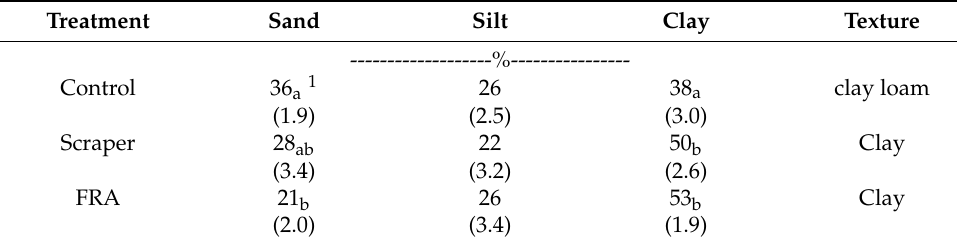
Table 1. Mean soil particle size distribution and textural class for each treatment followed by the standard error in parenthesis.